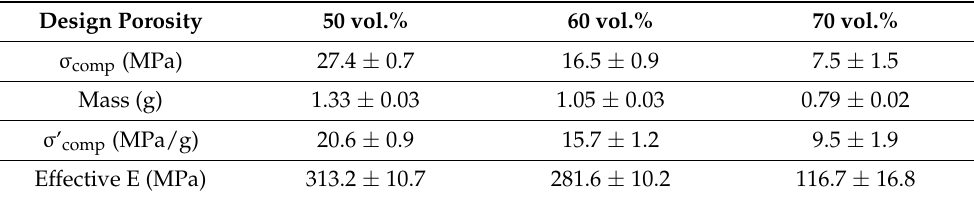
Table 3. Parameters measured and properties evaluated in aluminium foams.